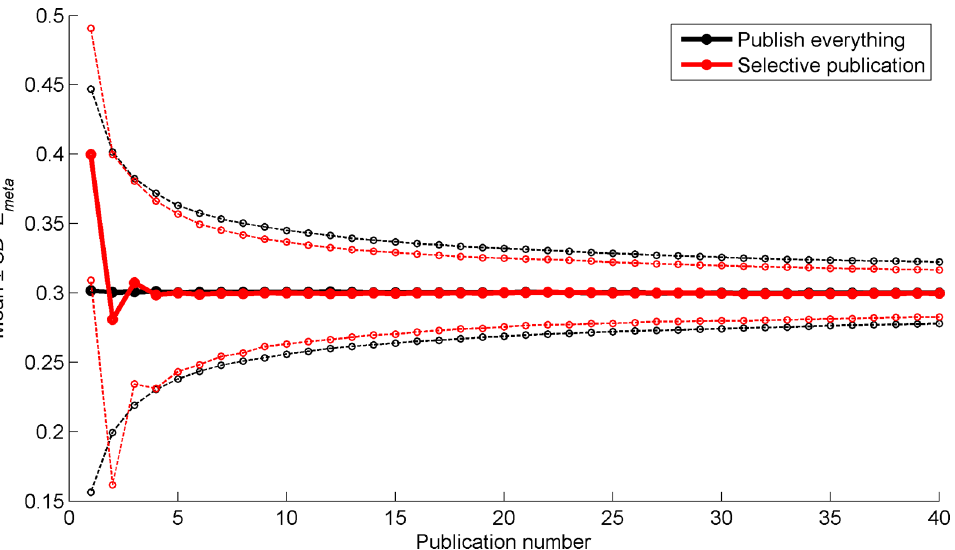
Figure 3. Mean (thicker solid lines) and mean plus/minus one standard deviation (thinner dashed lines) of the cumulative meta- analytic effect ( E meta ) as a function of the number of publications. The means and standard deviations are calculated across the 5,000